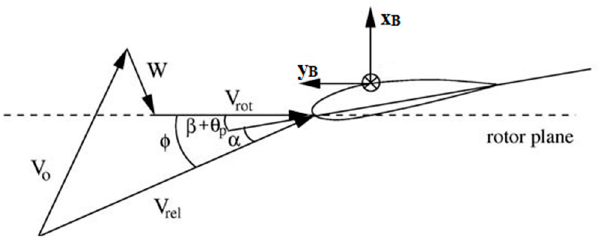
Figure 2. Velocity Triangle on a Blade Section [16].